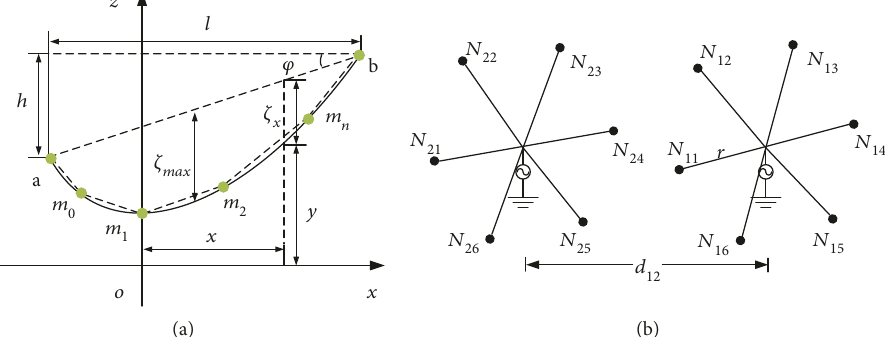
Figure 9: Schematics of the top wires and the down-lead wires. (a) The plane schematic of the top wires. (b) The topology diagram of down-lead wires.